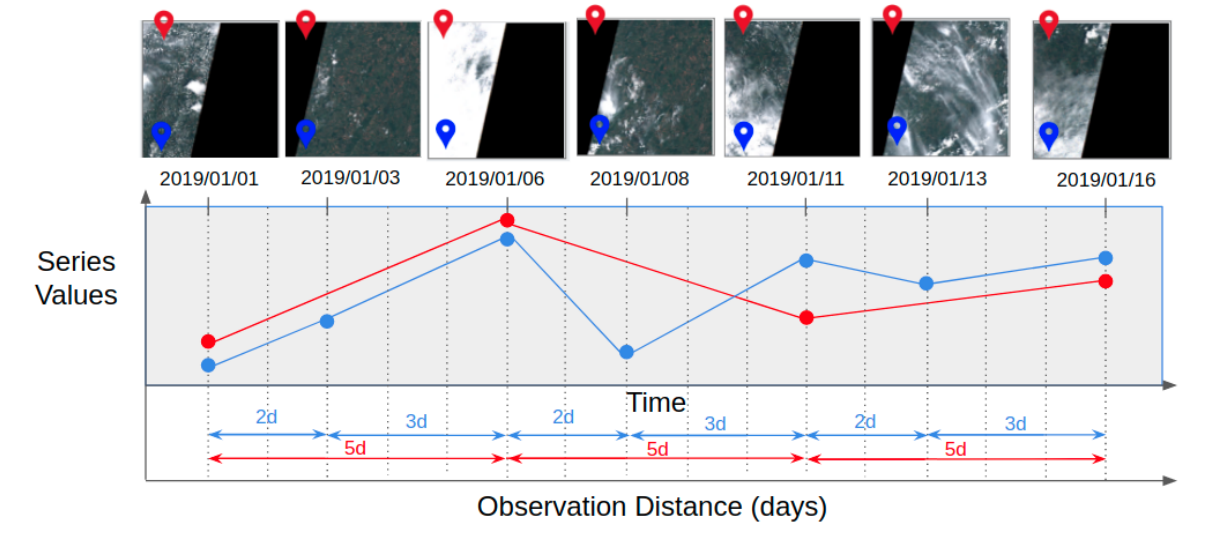
Figure 2. Time series extracted from identity EO data cubes can be regular in time (red time series) or not (blue time series).